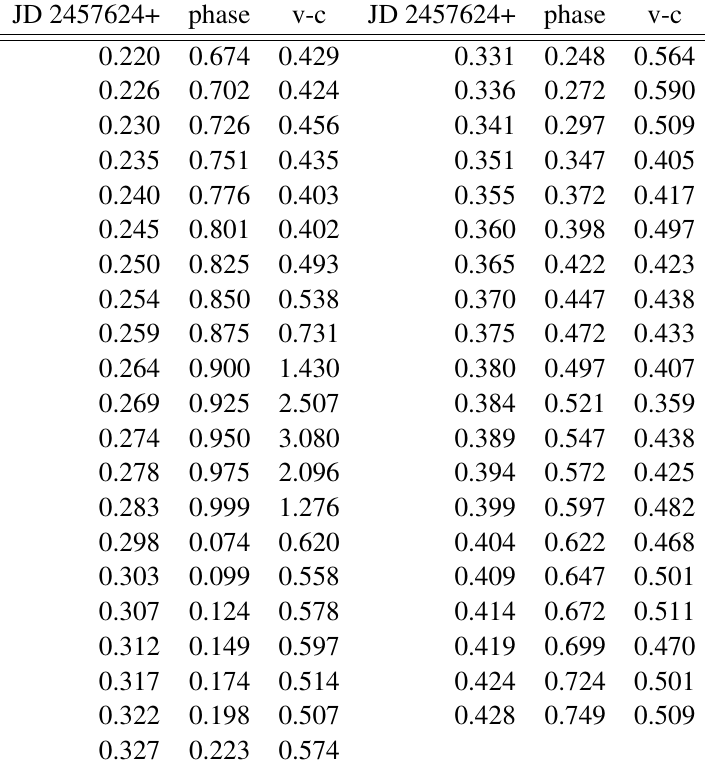
Table 5 list of CCD Photometry of DQ Her in R filter.